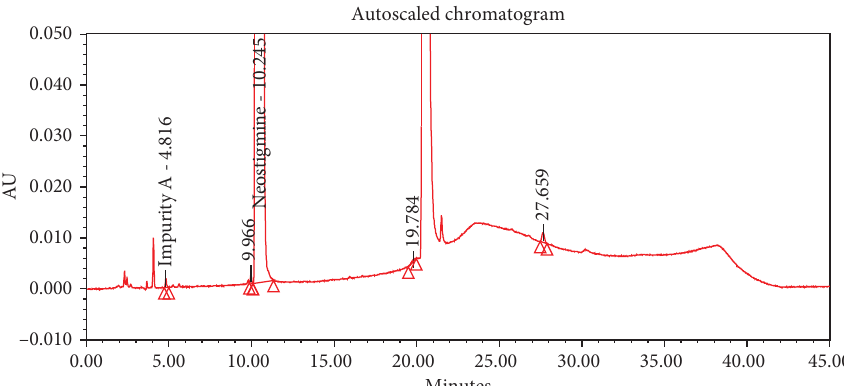
Figure 11: Chromatogram obtained from acid hydrolysis (1mL of 0.1N HCl) benchtop of neostigmine methylsulfate injection.